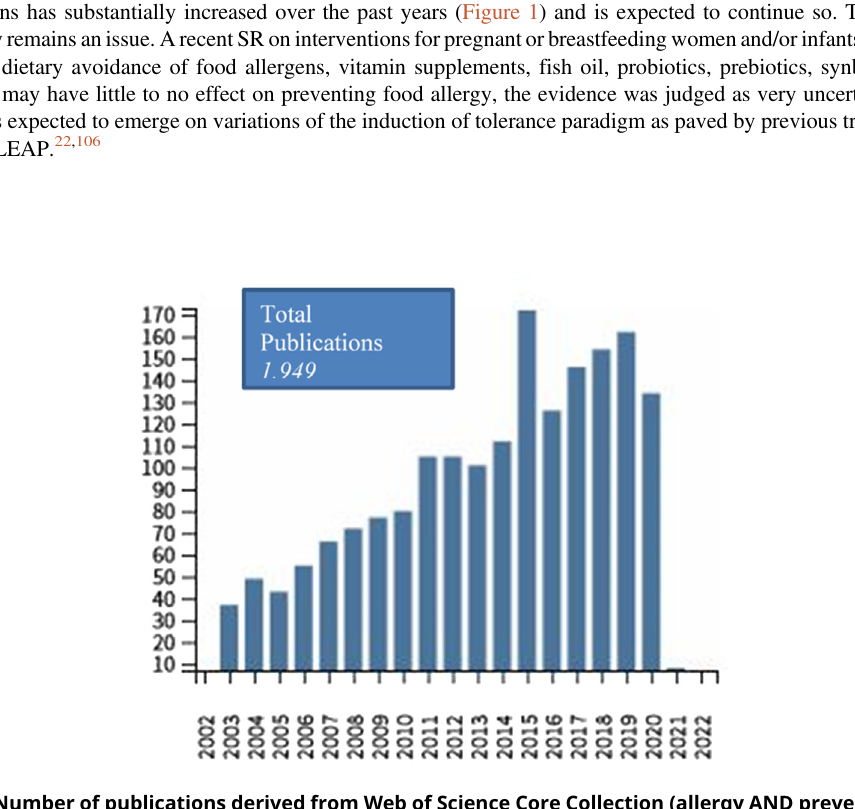
Figure 1. Number of publications derived from Web of Science Core Collection (allergy AND prevention AND childhood) per year since 2002 (performed